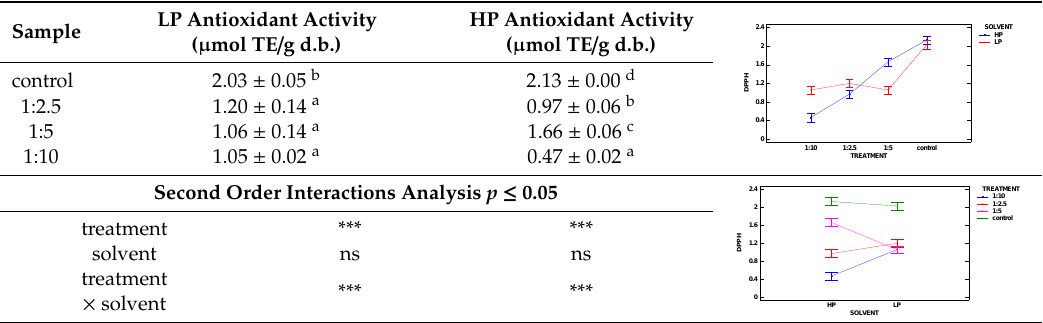
1:2.5, 1:5, 1:10-solid:liquid ratio of buckwheat grain samples ultrasound treated in water; control–sample of untreated buckwheat grain. LP–low polarity extracts made with acidified methanol, HP–high polarity extracts made with 50% methanol and 50% acetone (both with water),